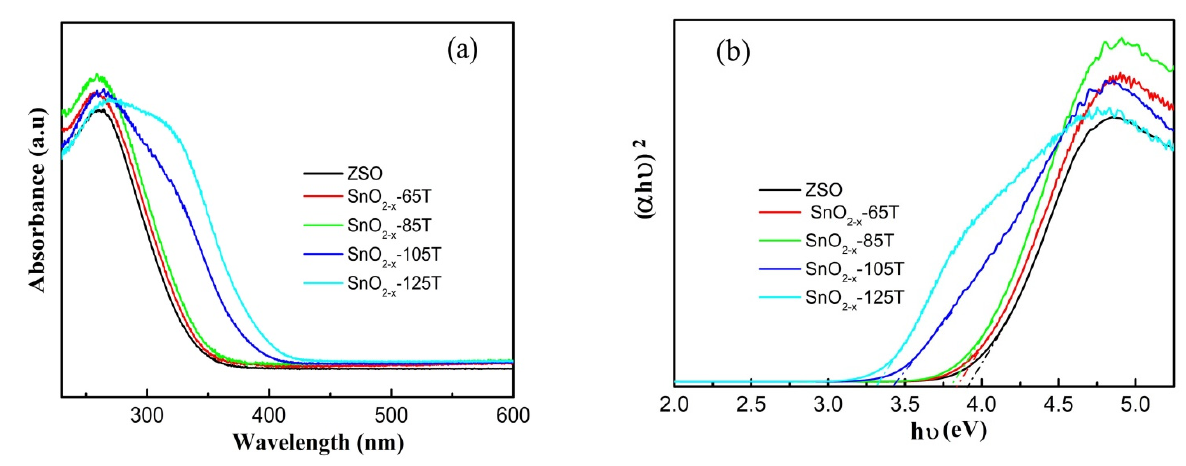
Figure 6. ( a ) UV–Vis absorbance spectra of the ZSO and SnO 2-x samples, ( b ) the derived plots of ( α h υ ) 2 versus h υ from the absorption spectrum for ZSO and SnO 2-x samples. ( α h υ ) 2 versus h υ from the absorption spectrum for ZSO and SnO